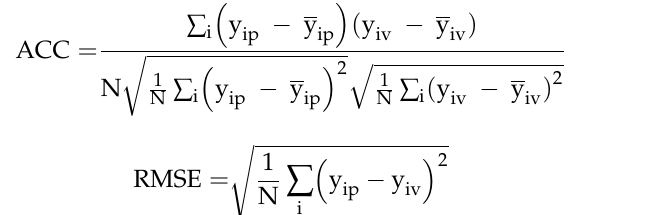
Table 2. A 2 × 2 contingency table for precipitation. Precipitation Events Events